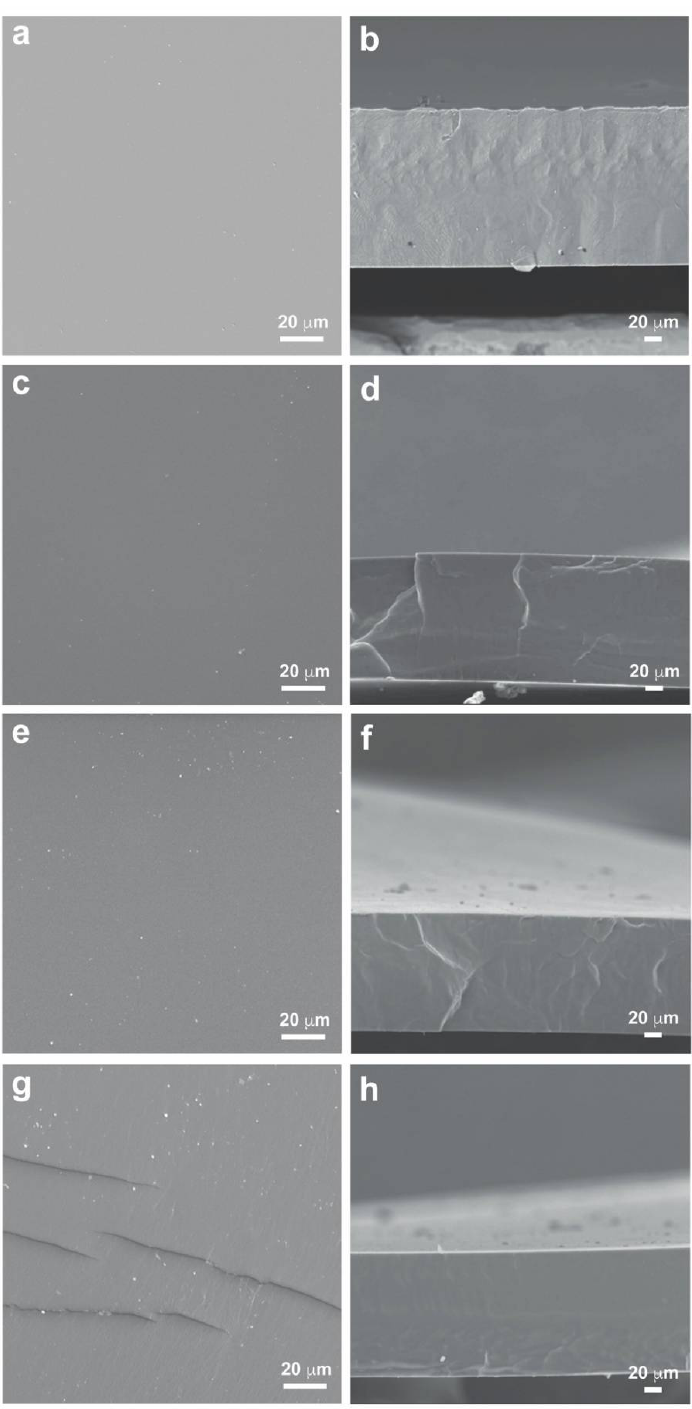
Figure 3. SEM images of the surface and cross of the non-porous symmetric PU-based membranes: ( a ) surface and ( b ) cross-section of the PU membrane, ( c ) surface and ( d ) cross-section of the PU/CR membrane, ( e ) surface and ( f ) cross-section of the of the PU/TRIS membrane, and ( g ) surface and ( h ) cross-section of the PU/MBCD